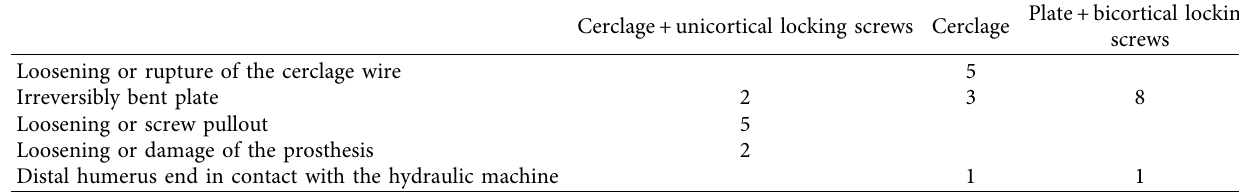
Table 2: An overview of the mechanisms of failure in each of the three